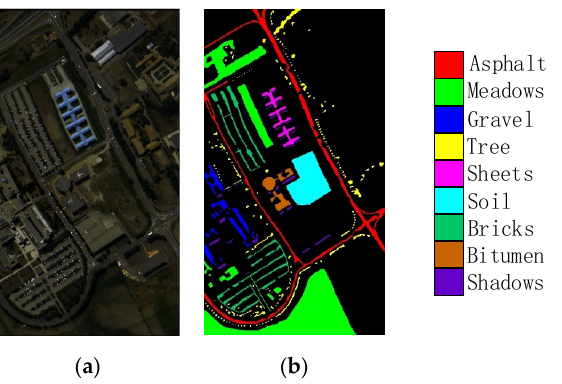
Figure 7. University of Pavia images: ( a ) pseudo-color image; ( b ) ground-truth labels. Table 4. Training and testing samples for the UP Dataset.